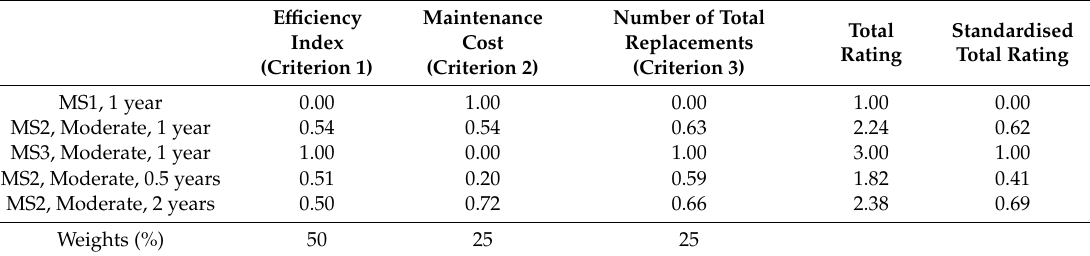
Table 10. Scenario 2: the higher weight of the e ffi ciency index.